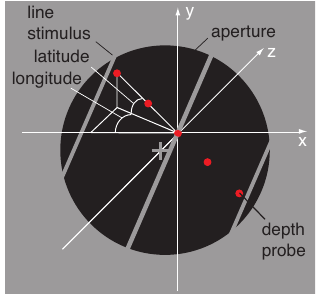
Figure 3. Illustration of the stimulus display and adjustment method. White hairlines indicate the axes ( x , y , and z ) and angles (longitude, latitude) in 3D and were not visible in the display. In each trial an oriented line stimulus moved back and forth on a 3D trajectory behind a circular aperture. The three grey lines illustrate a line stimulus at its far (left), start (centre), and near (right) position. The observer adjusted a string of five red dots until they matched the perceived 3D motion direction of the moving line stimulus. Motion direction was expressed in longitude and latitude angle, measured in degrees from the midpoint of the depth probe. See text for